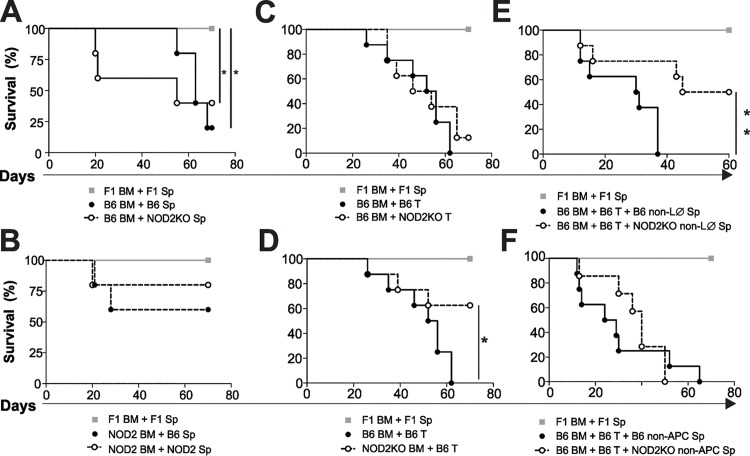
NOD2KO bone marrow myeloid cells protect mice from GVHD-related mortality.F1 (bxd) mice were lethally irradiated and received BM cells (5x106) along with splenocytes (corrected to 5x106 CD3+ cells) derived from F1, WT or NOD2KO as indicated (A-B). F1 mice (C57BL/6 x BALB/c) were lethally irradiated and received F1 WT BM cells and splenocytes as syngeneic control or (C) WT BM cells along with WT or NOD2KO purified T cells, (D) WT or NOD2KO BM cells along with WT purified T cells (E), WT BM cells and purified T cells along with B6 WT or NOD2KO non-T, non-B and non-NK spleen cells (non-LØ), (F) WT BM cells and purified T cells along with WT or NOD2KO non -CD11b, -CD11c, -CD4 and -CD8 spleen cells (non-APC). The results are represented as percent of surviving animals. Pooled results from 2 experiments; n = 10 animals per group. Log-rank test for trend. *p<0,05 and **p<0,01.